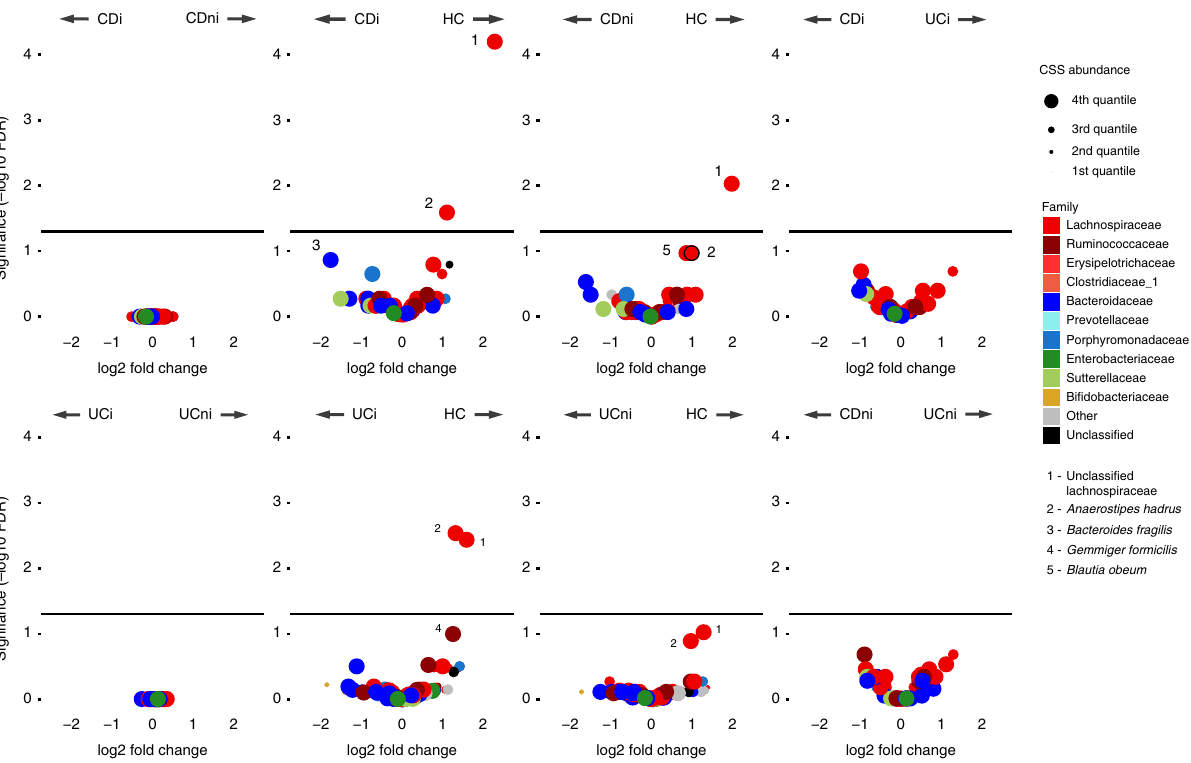
Fig. 2 Volcano plots showing differential abundance of RSVs between sample groups. Both in fl amed vs. non-in fl amed tests were based on paired biopsies only. y -axis show adjusted P value (false discovery rate) and x -axis shows log2 fold change. Horizontal lines re fl ect 0.05 FDR. Points are colored by family level classi fi cation based by Mothur against the RDP database v11.4. Circle sizes are assigned based on the mean cumulative-sum scaling (CSS) and divided into quartiles with the larger circles corresponding to higher abundances. Species discussed in the text are explicitly listed; see Supplementary Table 3 for a complete